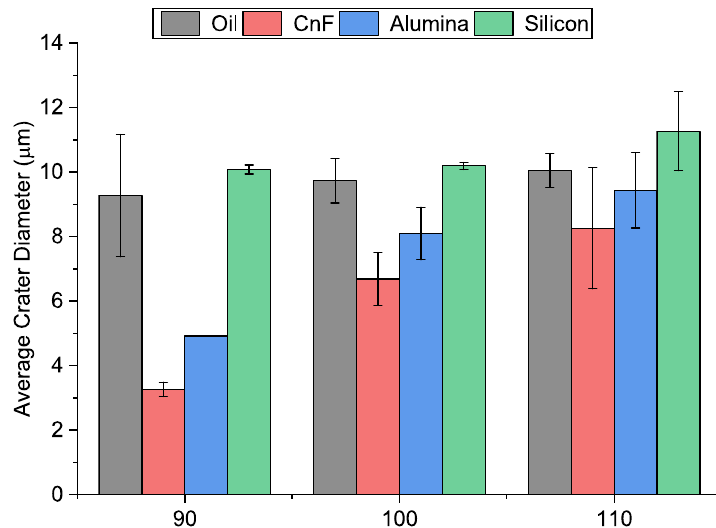
Figure 7. Average single discharge crater diameter under different